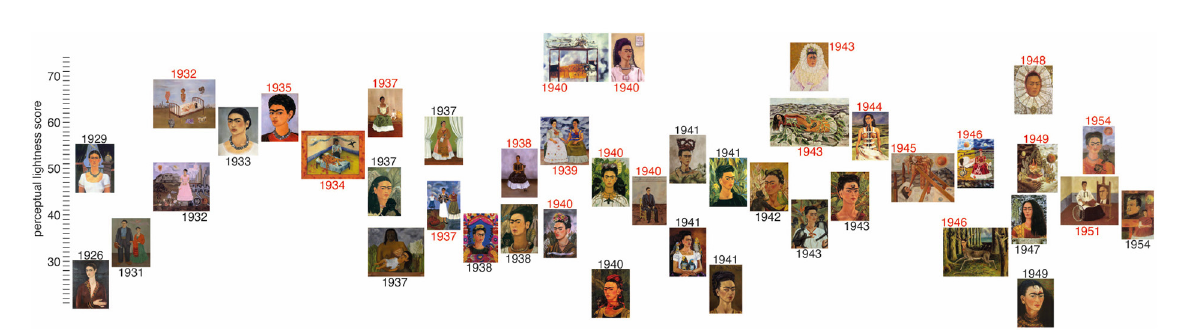
FIGURE1 Timeline of the self-portraits of Frida Kahlo where the y-value of each canvas indicates the perceived luminance L * . The dates of the portraits that were scored 1 for physical or emotional pain are shown in